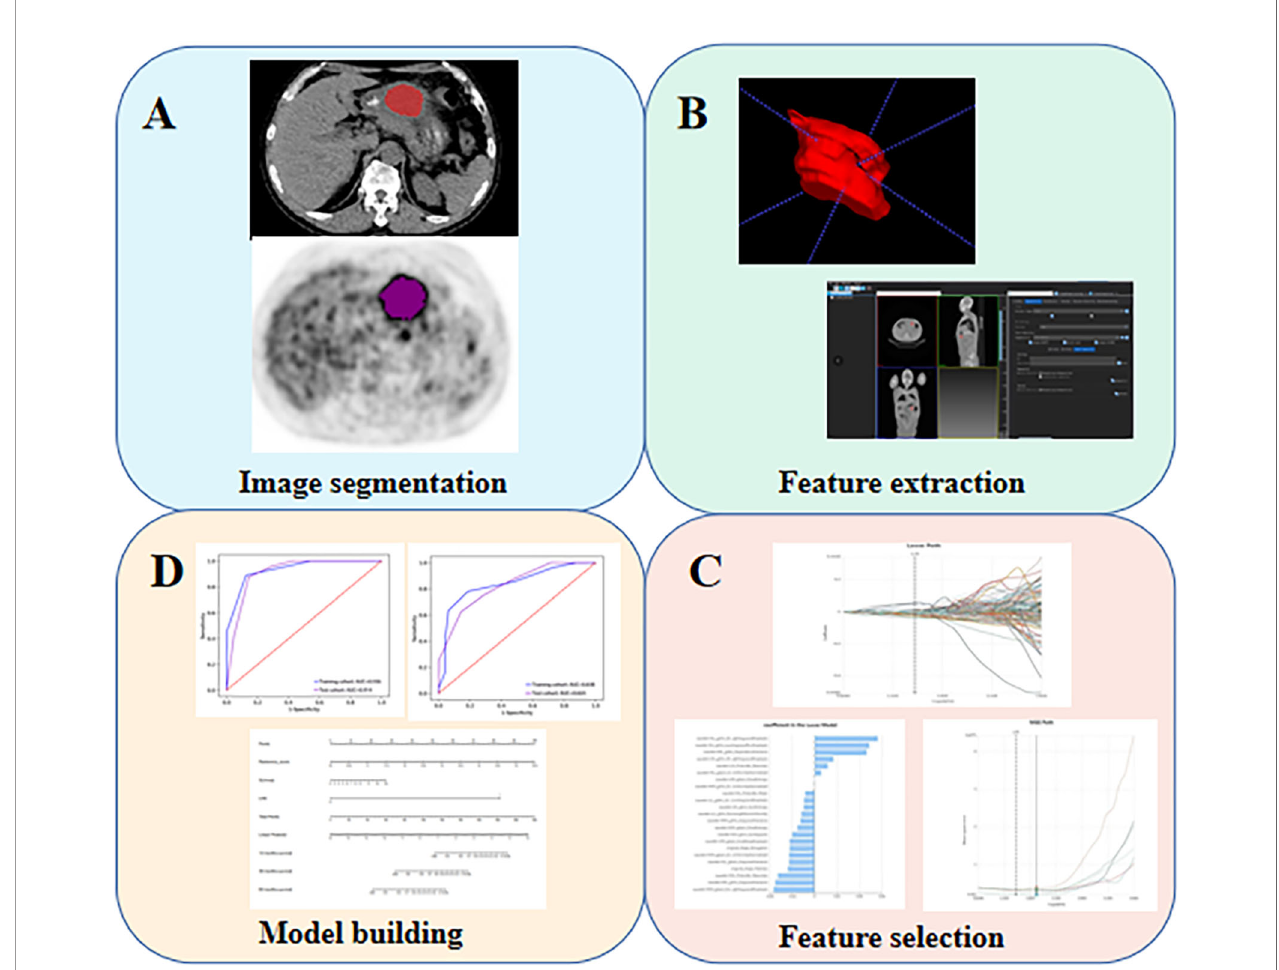
FIGURE 1 | The fl ow diagram of this study. (A) Image segmentation; (B) Feature extraction; (C) Feature selection; (D) Model